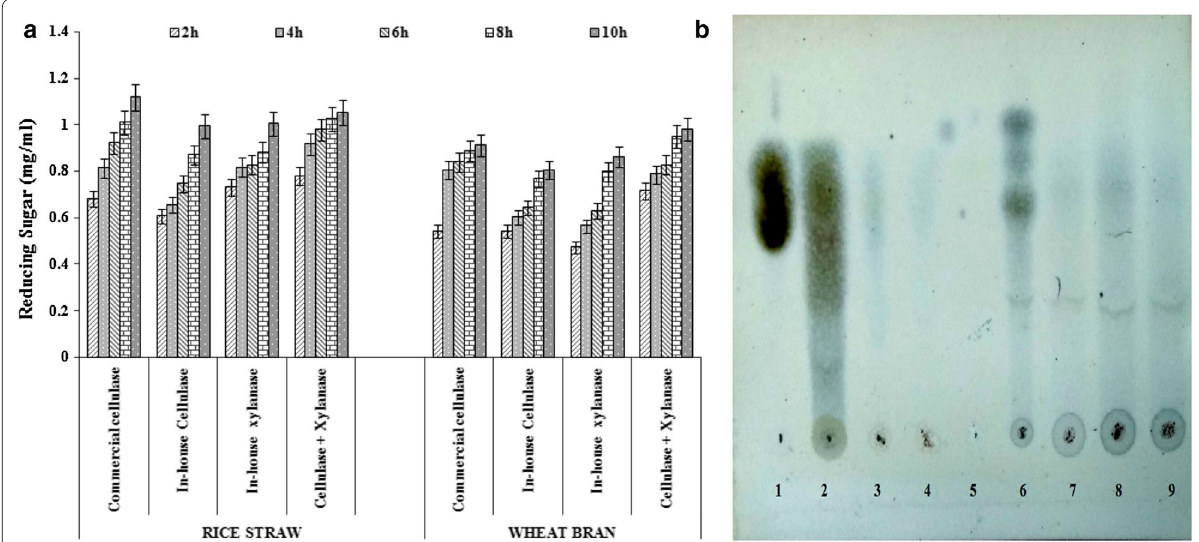
Fig. 5 Hydrolysis of rice straw and wheat bran. a Hydrolysis of rice straw and wheat bran for the detection of amount of sugar released with time by using commercial cellulase ONZUKAR, cellulase obtained from Schizophyllum commune NAIMCC-F-03379, xylanase obtained from A. oryzae and combination of cellulase and xylanase. b Analysis of hydrolysis product. Glucose as control (1), rice straw by commercial cellulase (2), rice straw by cellulase obtained from Schizophyllum commune NAIMCC-F-03379 (3), rice straw by xylanase obtained from Aspergillus oryzae (4), rice straw by combination of cellulase and xylanase (5), wheat bran by commercial cellulase (6), wheat bran by cellulase obtained from Schizophyllum commune NAIMCC-F-03379 (7), wheat bran by xylanase obtained from Aspergillus oryzae (8) and wheat bran by combination of cellulase and xylanase (9) on TLC